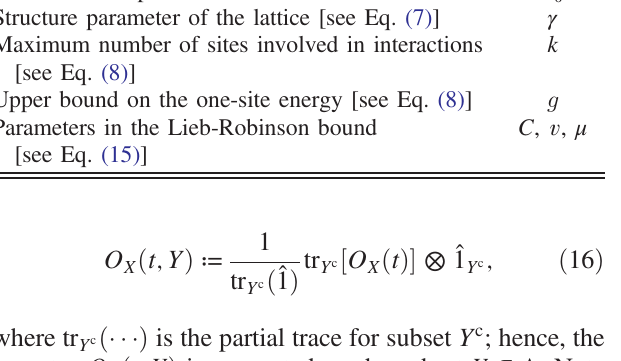
TABLE I. Fundamental parameters in our statements. Definition Local Hilbert space dimension Structure parameter of the lattice [see Eq. (7)] Maximum number of sites involved in interactions [see Eq. (8)] Upper bound on the one-site energy [see Eq. (8)] Parameters in the Lieb-Robinson bound [see Eq.